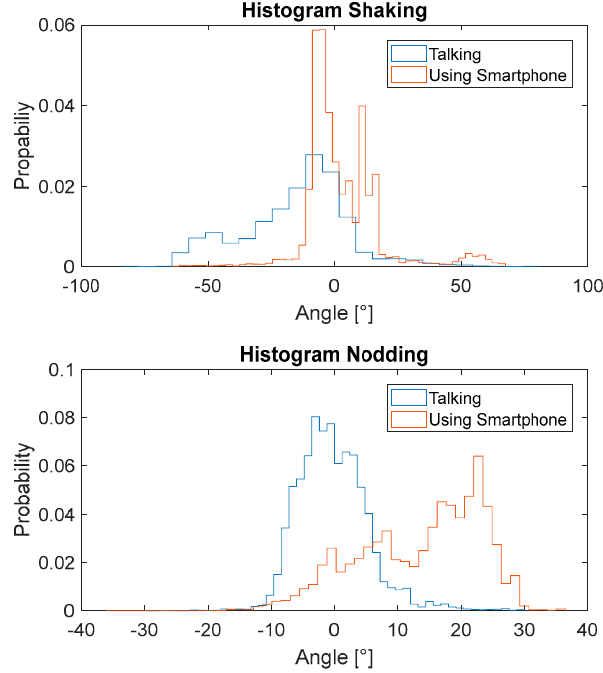
Figure 16. Histograms of the 3D angles for two tested NDAs.